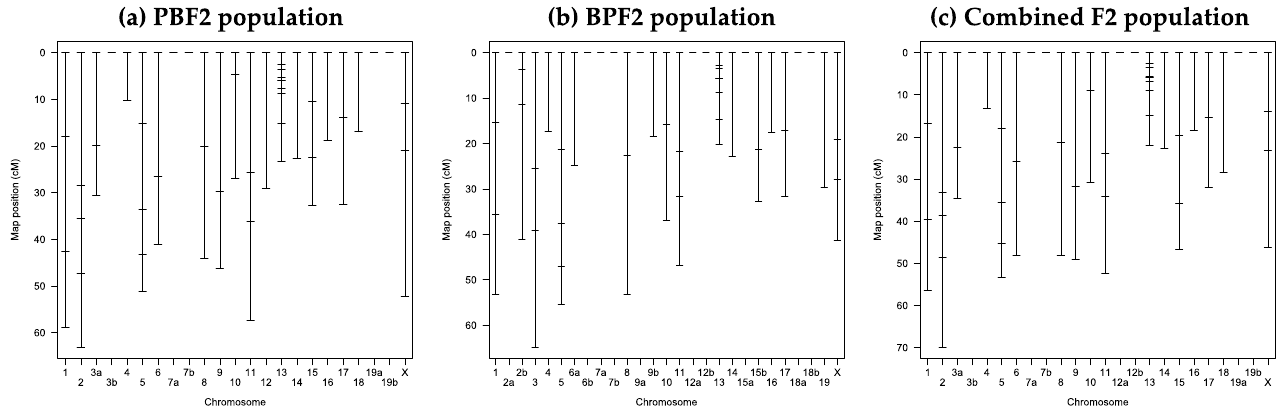
Figure 4. Genetic linkage maps of 69 DNA markers developed in this study: ( a ) PBF2 population; ( b ) BPF2 population; ( c ) combined F2 population. See Tables S2 and S5–S7 for details of the markers and linkage groups constructed. The small horizontal line on the linkage group indicates the position of the DNA marker.